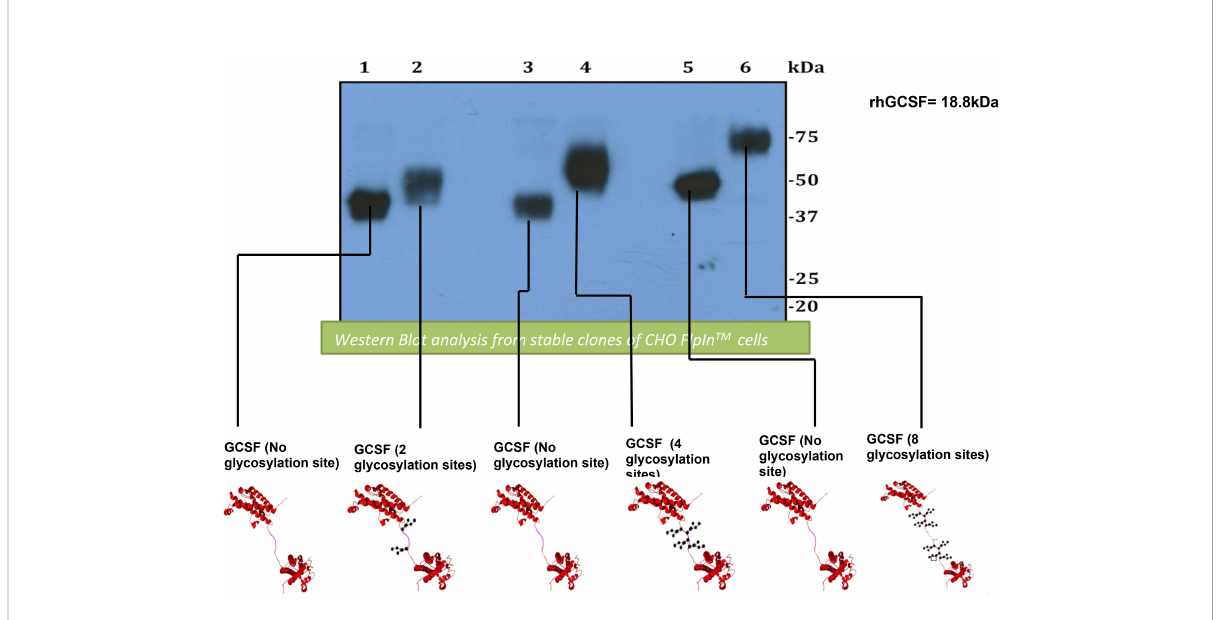
FIGURE 3 Analysis of Western blot expressing and comparing G-CSF tandems and their controls. First lane, GCSF2QAT_control (2 × QAT). Second lane, GCSF2NAT (2 × NAT). Third lane, GCSF4QAT_control (4 × QAT). Fourth lane, GCSF4NAT (4 × NAT). Fifth lane, GCSF8QAT_control (8 × QAT). Sixth lane, GCSF8NAT (8 × NAT). Analysis of Western blot displays an obvious increase in molecular weight for glycosylated GCSF tandems (GCSF2NAT, GCSF5NAT, and GCSF8NAT) when compared with non-glycosylated controls (GCSF2QAT, GCSF4QAT, and